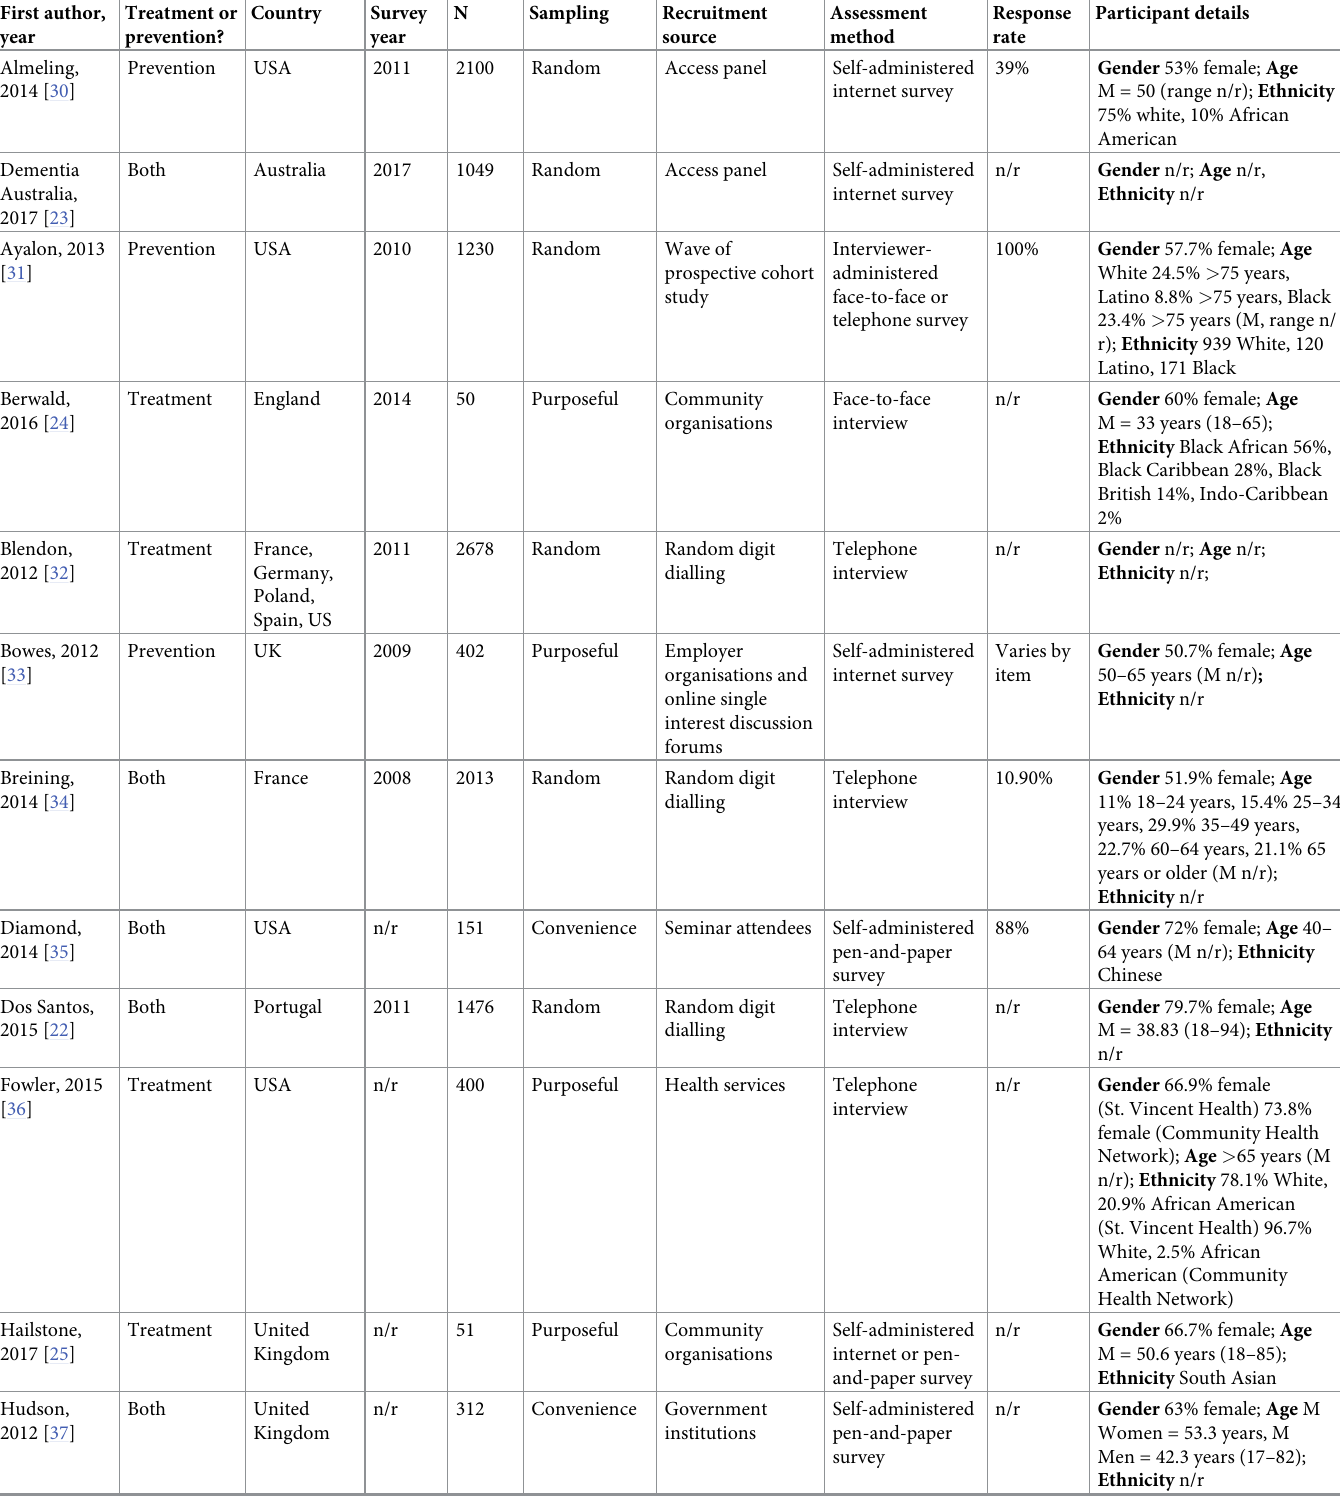
Table 1. Included study